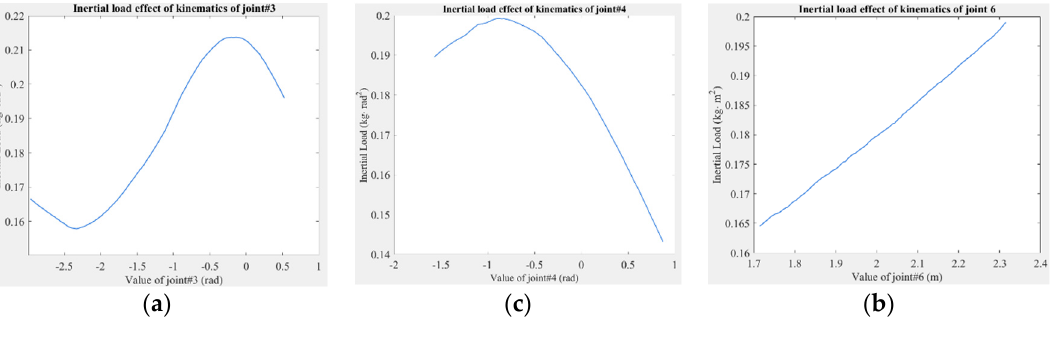
Figure 7. Inertial load effect of kinematics of joint 3—( a ), joint 4—( b ), joint 6—( c